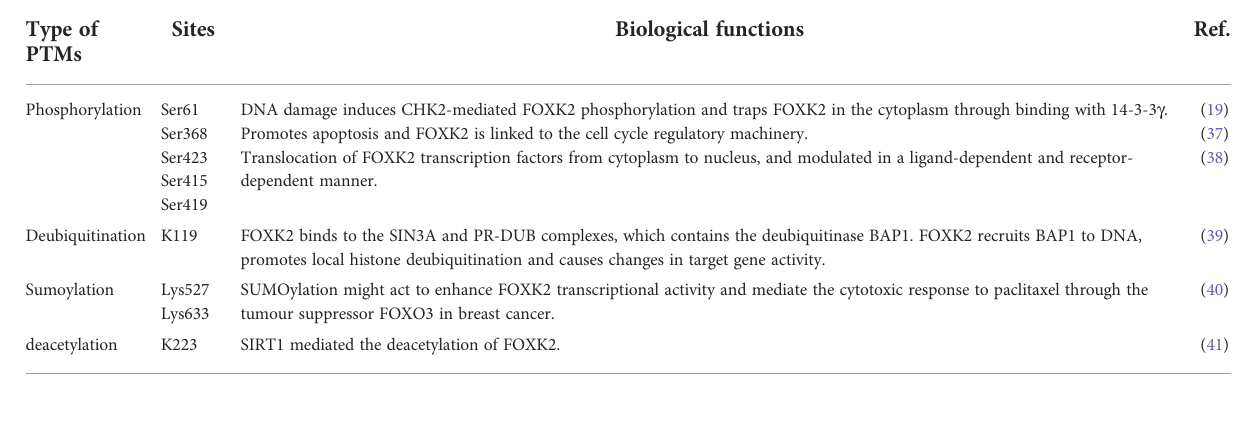
TABLE 2 Regulation of FOXK2 through PTMs and their